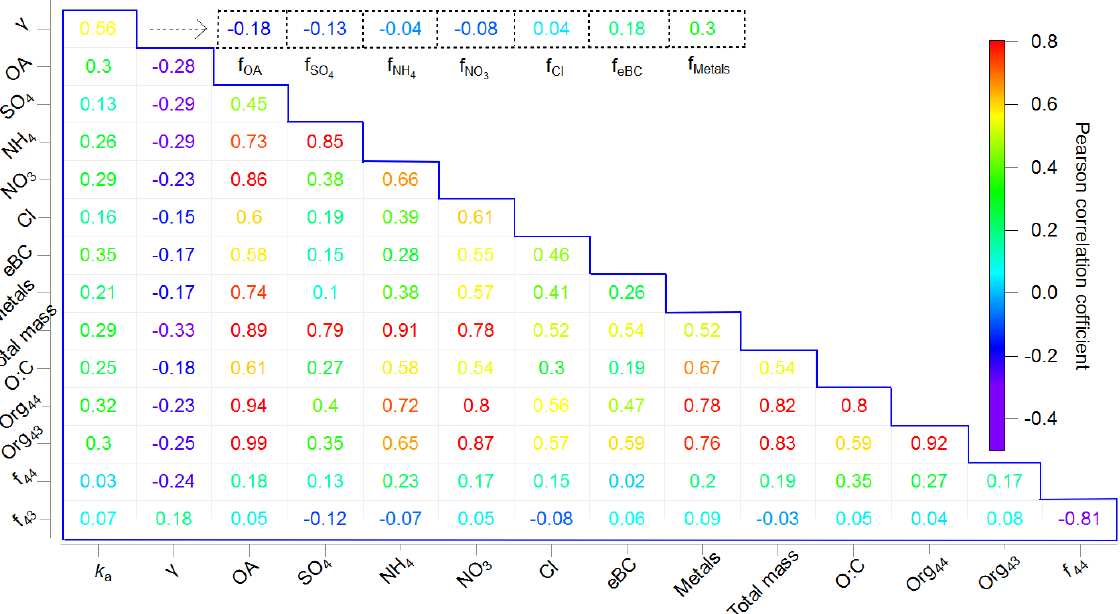
Figure 3. Correlation matrix showing Pearson’s r values for the chemical compositions, k a , and γ during the corresponding measurement periods (in the blue box) as well as Pearson’s r values for the chemical composition fraction i (represented as f i , i = OA, SO 2 − NO − , Cl − , eBC, and metals) and γ (in the dashed line 3